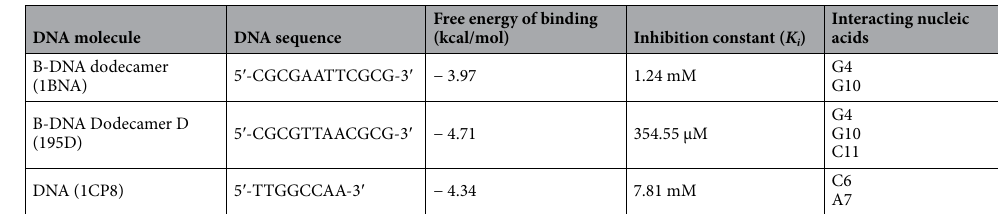
Table 8. The binding energy of the interacted pendimethalin with DNA molecules.